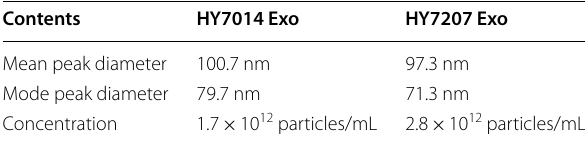
Table 1 Sze distribution analysis of